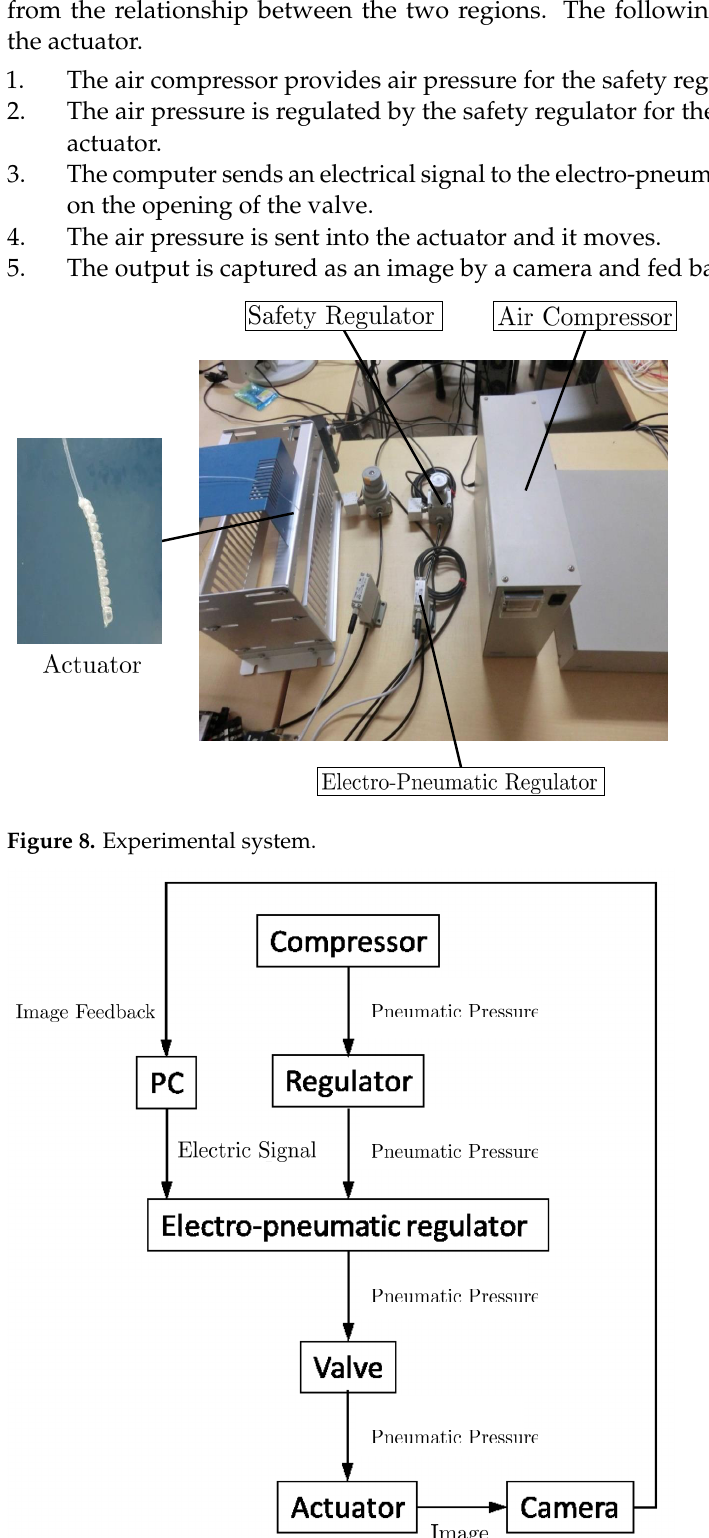
Figure 9. Experimental